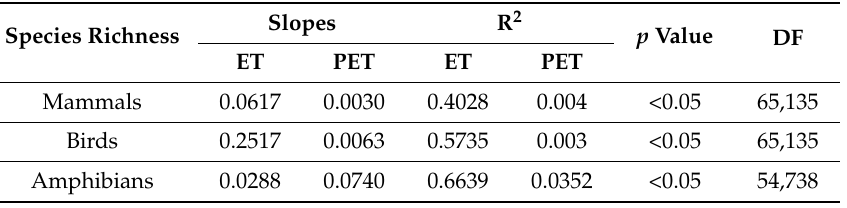
Table 1. Correlation coefficients of species richness based on field surveys versus remote sensing-based ET and PET using a simple linear regression of raw data.